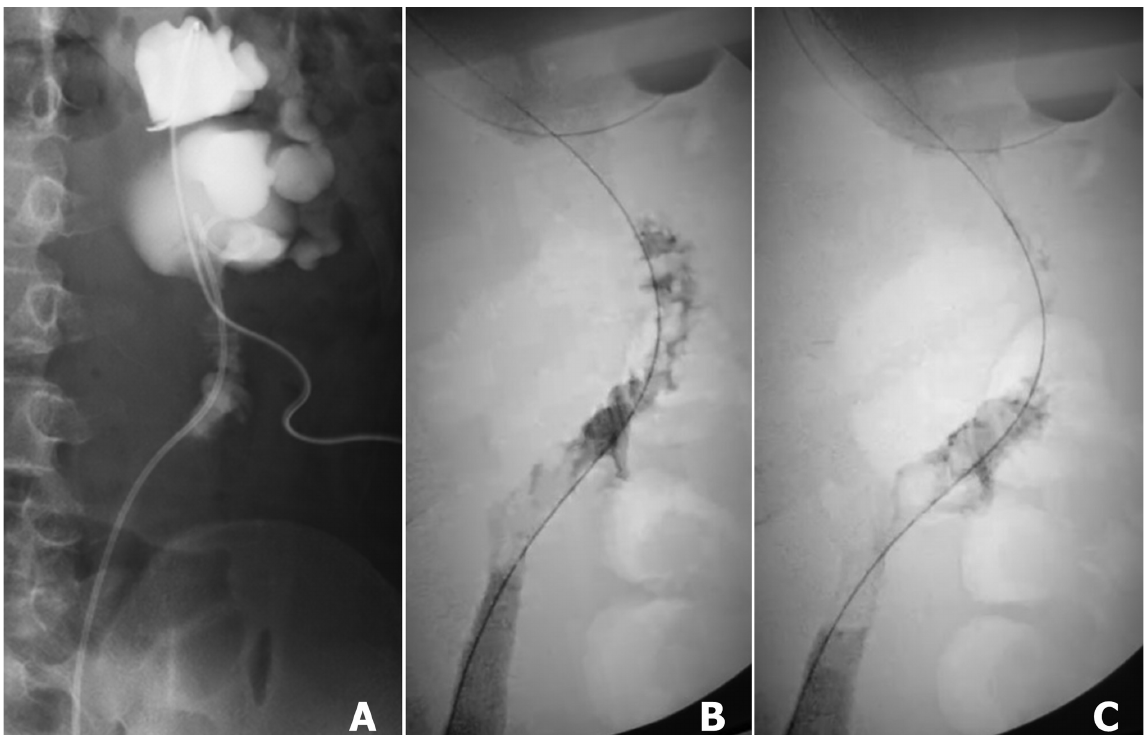
Fig. 2 Postoperative urography. Smooth urine fl ow through the ( A ) calyx – tapered segment of descending colon (TDC) anastomosis 13 days postoperatively and through the ( B,C ) ureter – TDC anastomosis 49 days postoperatively. European Journal of Pediatric Surgery Reports Vol. 11 No. 1/2023 © 2023. The